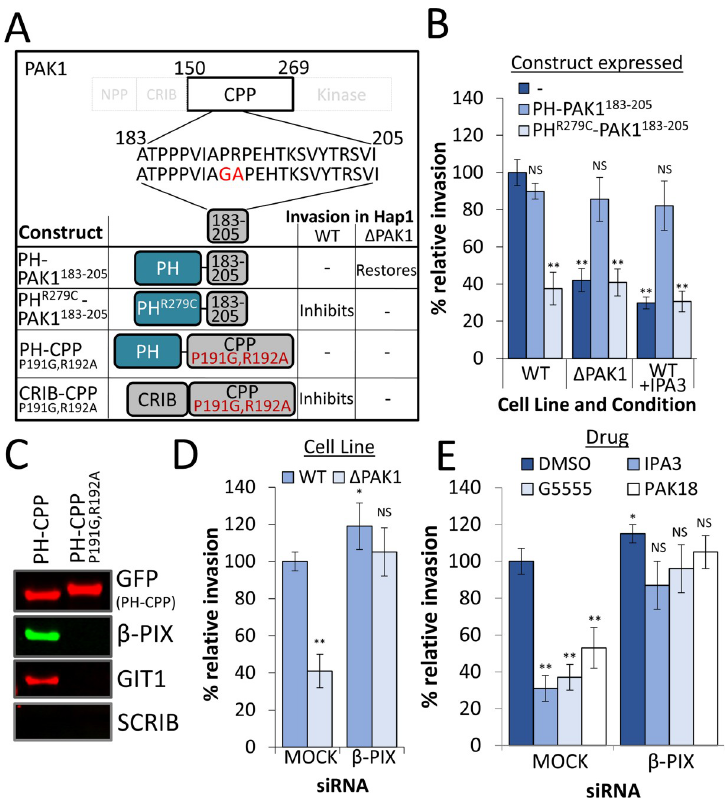
Fig 4. The interaction between PAK and β -PIX is crucial for Salmonella invasion, yet β -PIX depletion restores invasion in the absence of PAK. (A) The position and sequence of the central polyproline motif (PAK1 183-205 ), and residues mutated within this region. Also shown are the constructs expressed in (B) : PAK1 polyproline motif fused to a PH domain (PH- PAK1 183-205 ), the same domain fused to a mutated PH domain incapable of interacting with phospho-lipids (PH R279C -PAK1 183-205 ), CPP mutant unable to interact with SH3-containing proteins, fused to either PH domain (PH-CPP P191G,R192A ), or the PAK1 CRIB domain (CRIB-CPP P191G,R192A ). (B) Invasion of WT Salmonella into WT, Δ PAK1 or WT Hap1 cells pretreated with IPA3. Cells expressed the indicated construct. (C) Immunoblot of proteins that interact with PH-CPP and PH-CPP P191G,P192A . Emerald-tagged PH-CPP or PH-CPP P191G,R192A were expressed in Δ PAK1 Hap1 cells 48 hrs prior to being isolated using a GFP-Trap. Total extracted protein was detected using a GFP antibody, and β -PIX, GIT1 and SCRIB using corresponding antibodies. (D) Invasion of WT Salmonella into WT or Δ PAK1 Hap1 cells pretreated with mock or β -PIX siRNA (72 hrs prior to infection). Invasion is relative to mock siRNA-treated WT Hap1 cells. (E) Invasion of WT Salmonella into WT Hap1 cells pretreated with DMSO (control) or one of the PAK inhibitors IPA3, G5555 or PAK18, and also either pretreated with mock or β -PIX siRNA (72 hrs prior to infection). Invasion values are relative to mock siRNA, DMSO treated cells. All Error bars indicate SD. NS–no significant difference, �� —P < 0.01, � P < 0.05 (ANOVA followed by a post hoc Dunnett’s